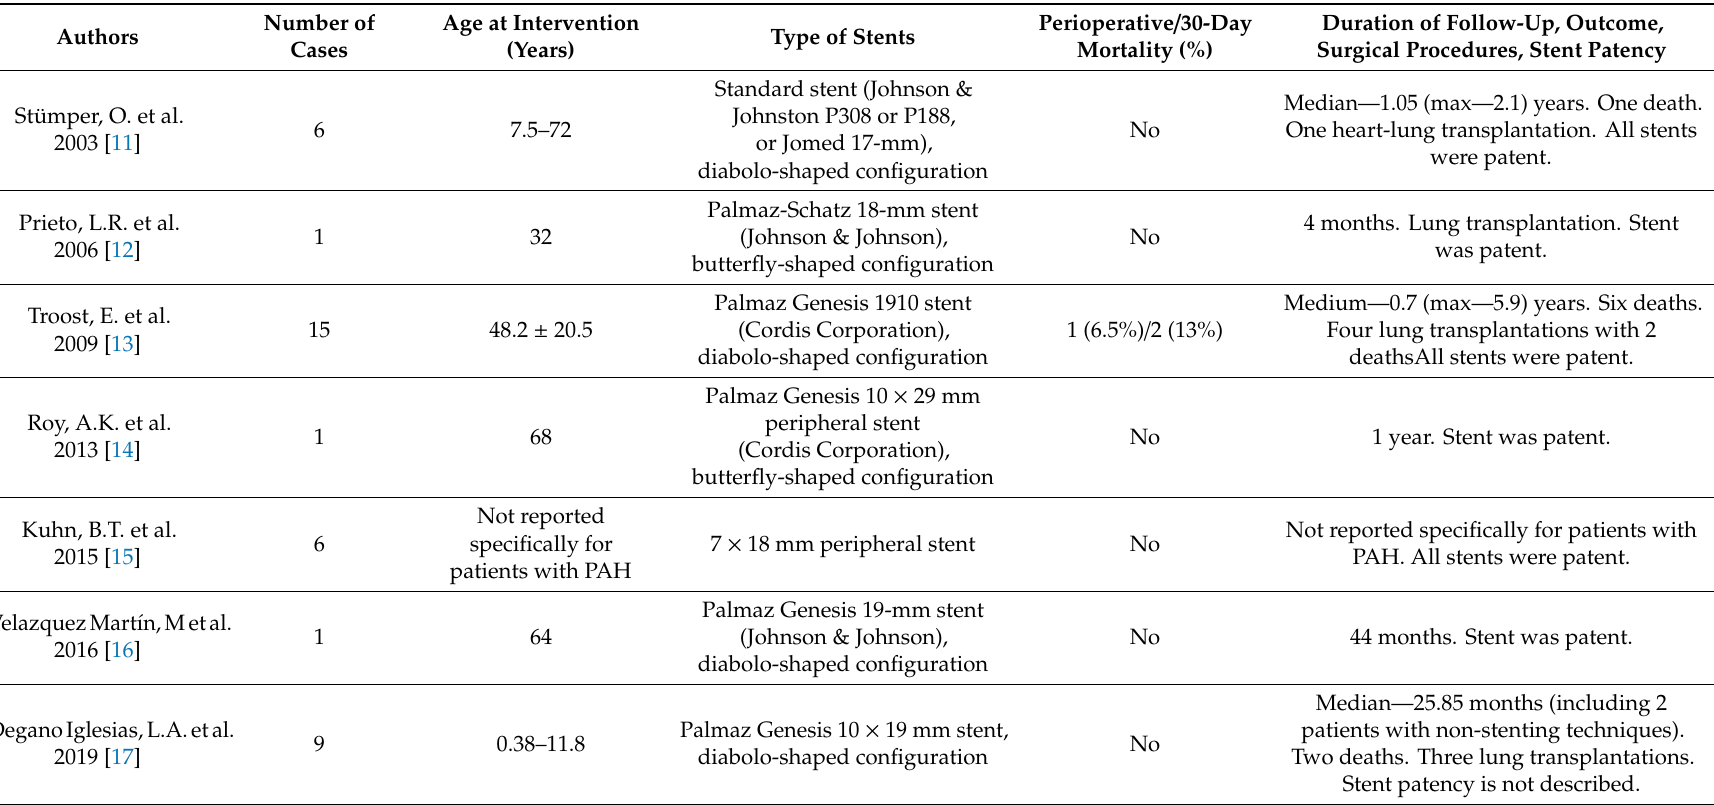
Table 1. Atrial septostomy with stents in patients with pulmonary arterial hypertension (PAH): world